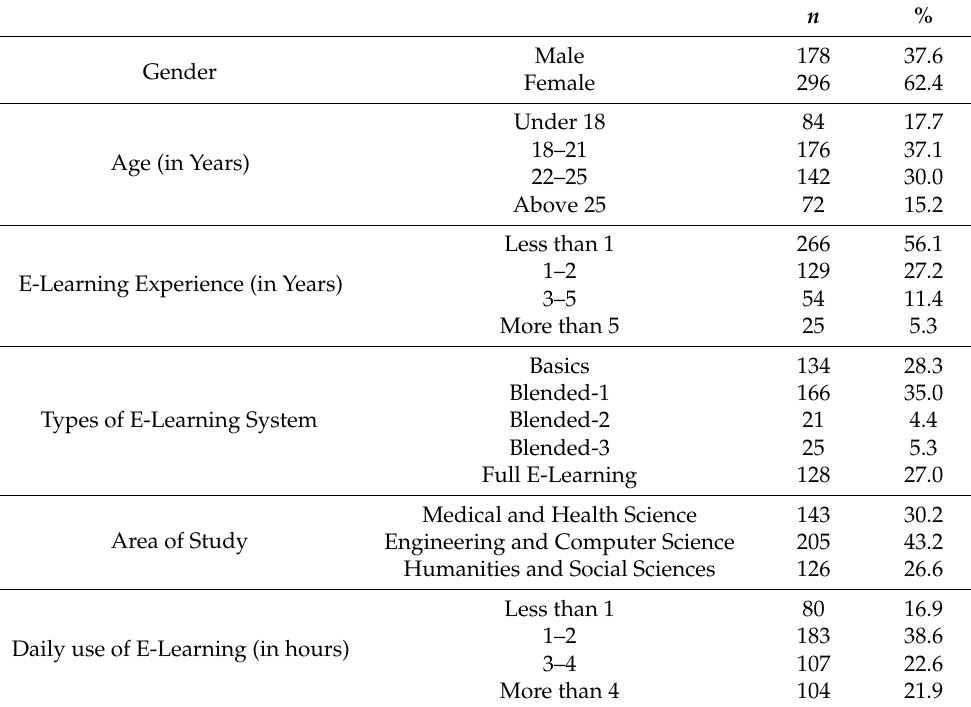
Table 1. Demographic profile of